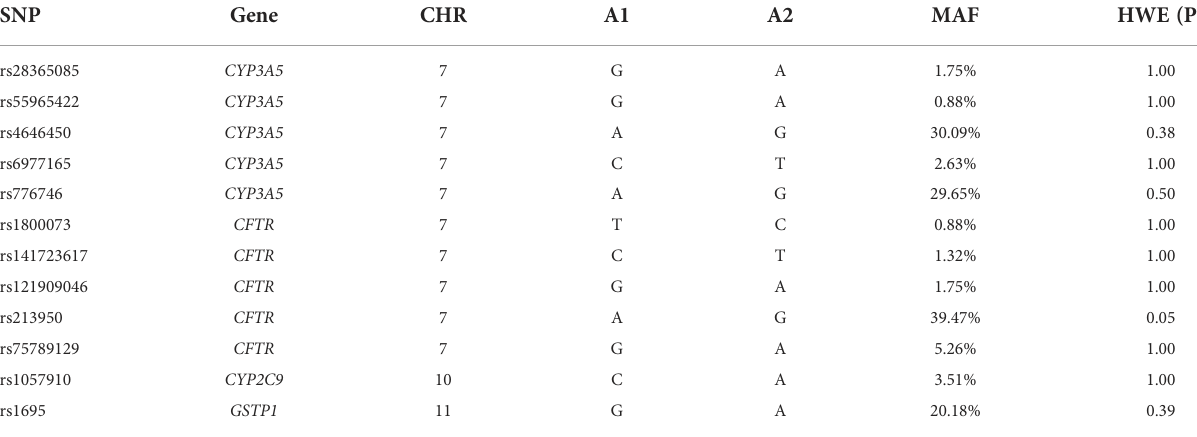
TABLE 2 SNPs of VIPDEGs included in the study.